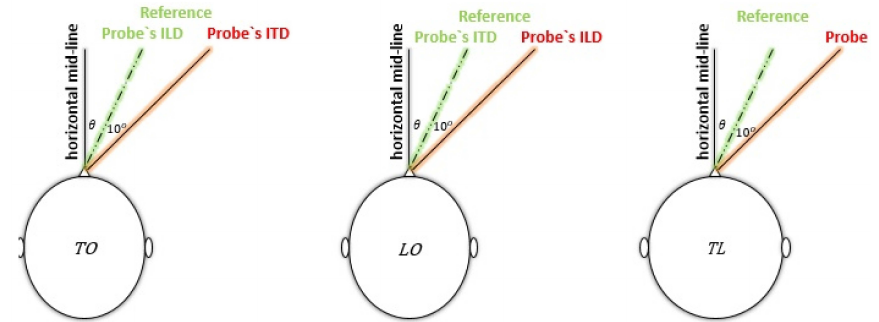
Figure 2. A sample visualization of probe sounds from azimuth ( θ + 10 ◦ ) for ime-only (TO), level-only (LO), and time-level (TL) conditions where the reference sound is from azimuth ( θ ) and direction of lateralization shift is